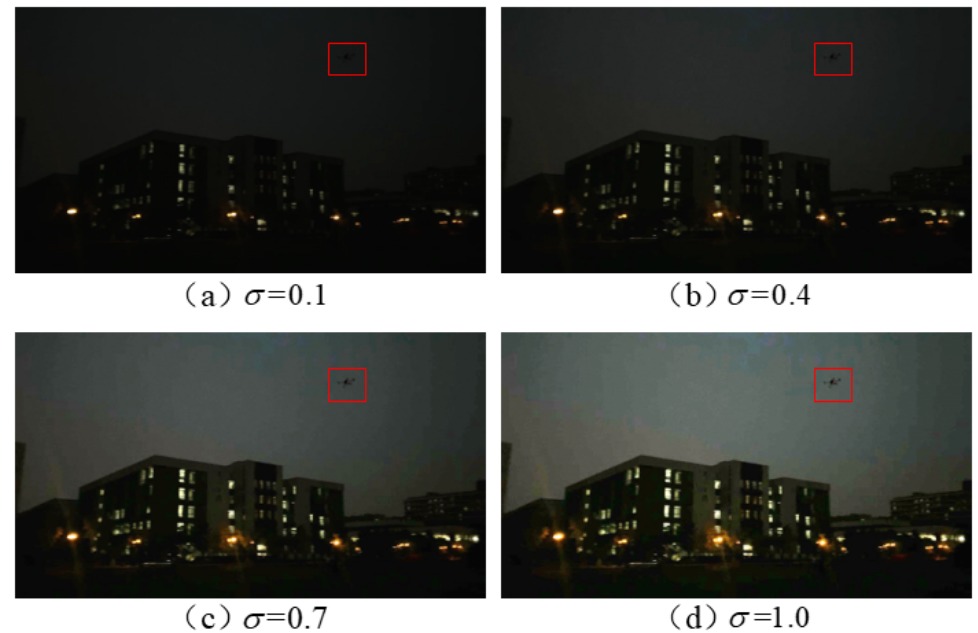
Figure 8. Enhanced results of Video 2 (containing the DJI F450 obstacle object) at different σ values.